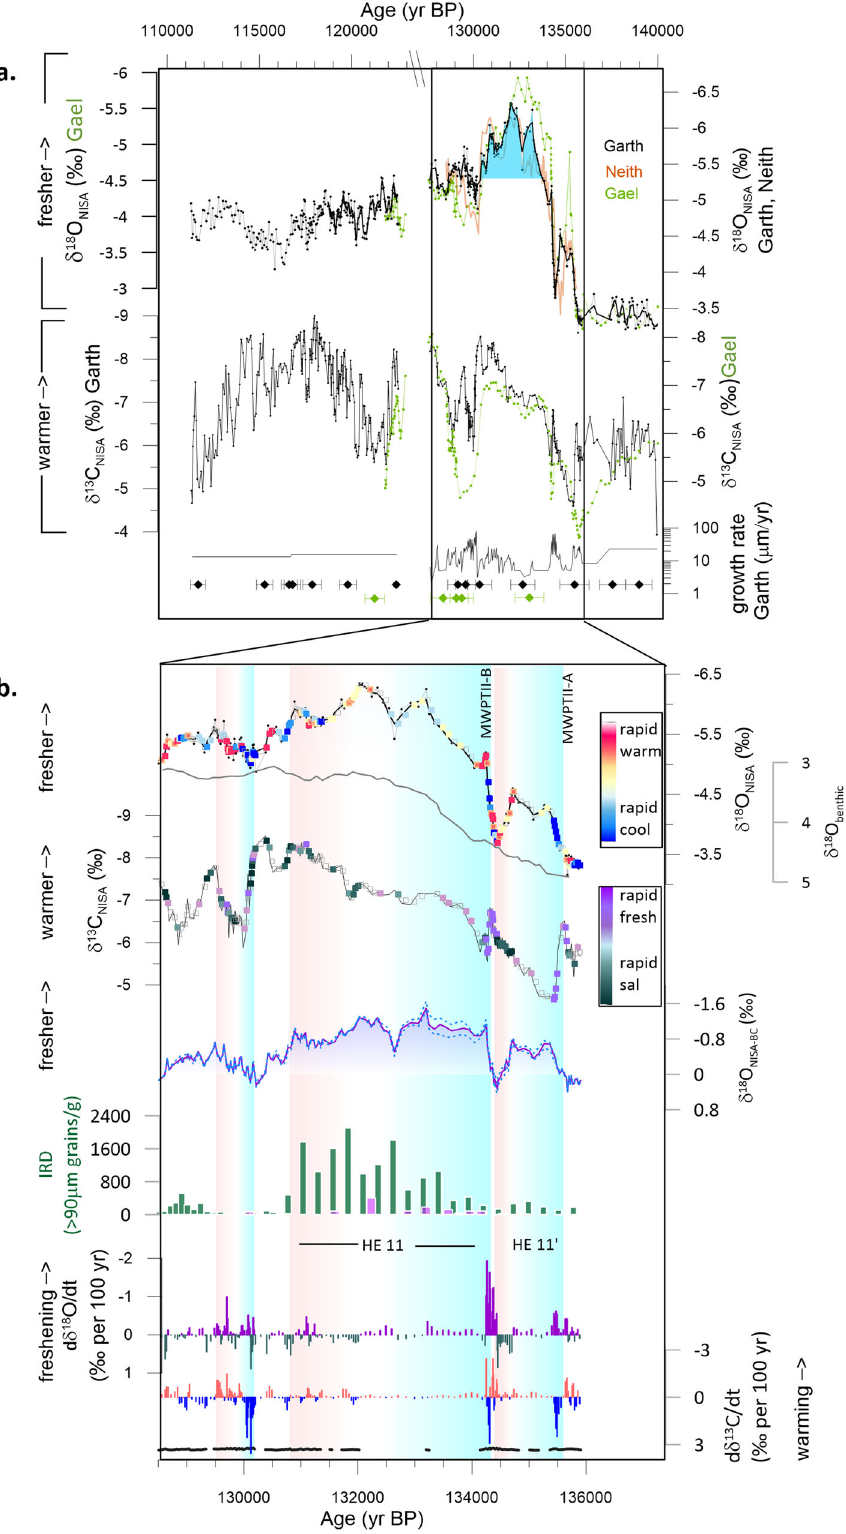
LGM sea level and benthic δ 18 O, this simulated large PGM EIS likely coexisted with a smaller than LGM NAIS 46 . The ice sheet reconstruction featuring a large TII EIS 46 encompasses a 2.5 – 3.5x greater volume of marine-grounded (grounded below paleo sea level) EIS ice at the PGM, compared to the LGM (Methods)